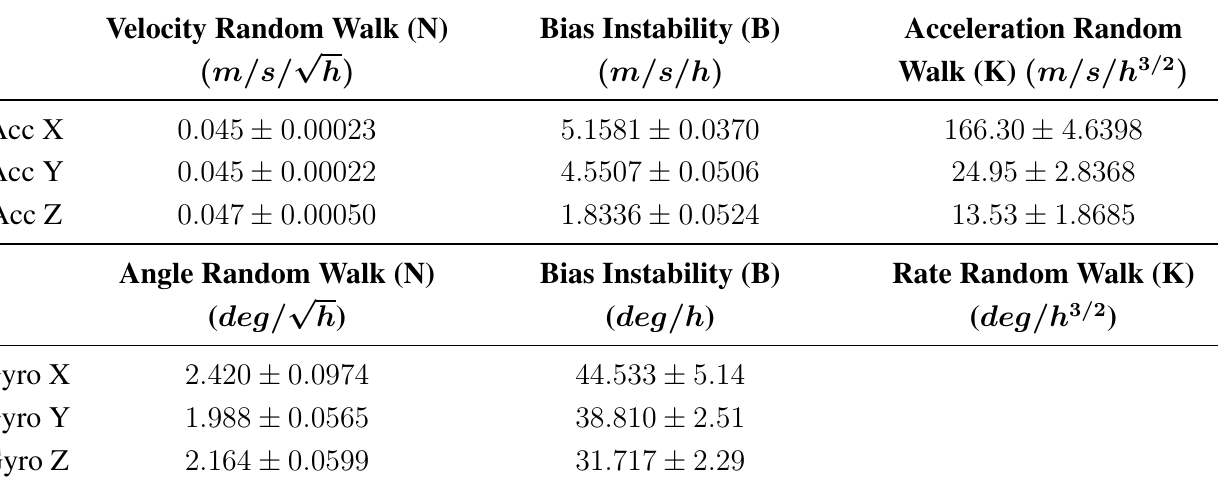
Table 4. Identified error coefficients for accelerometers and gyro of the 3DM-GX3 IMU with AV.